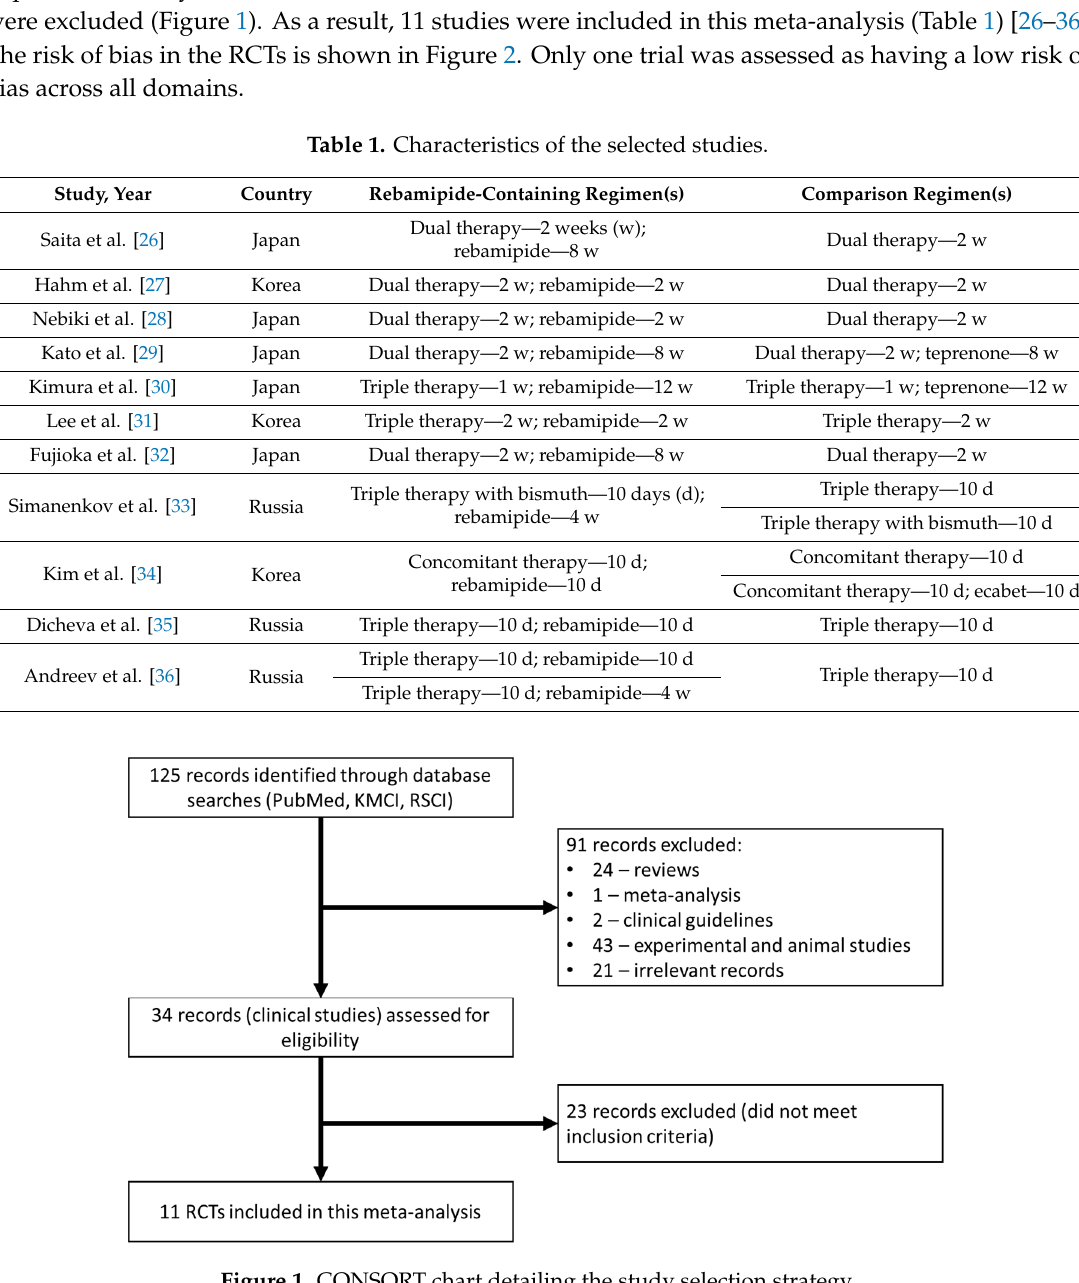
Table 1. Characteristics of the selected studies.